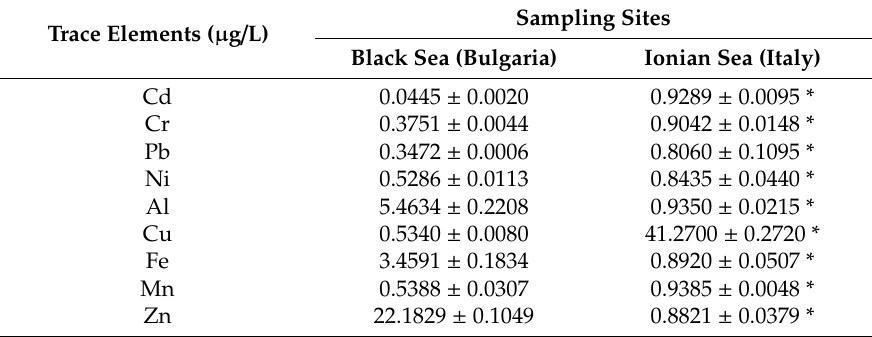
Table 2. Trace element concentration (mean ± SD) measured in the seawater of the Black Sea (Bulgaria) and the Ionian Sea